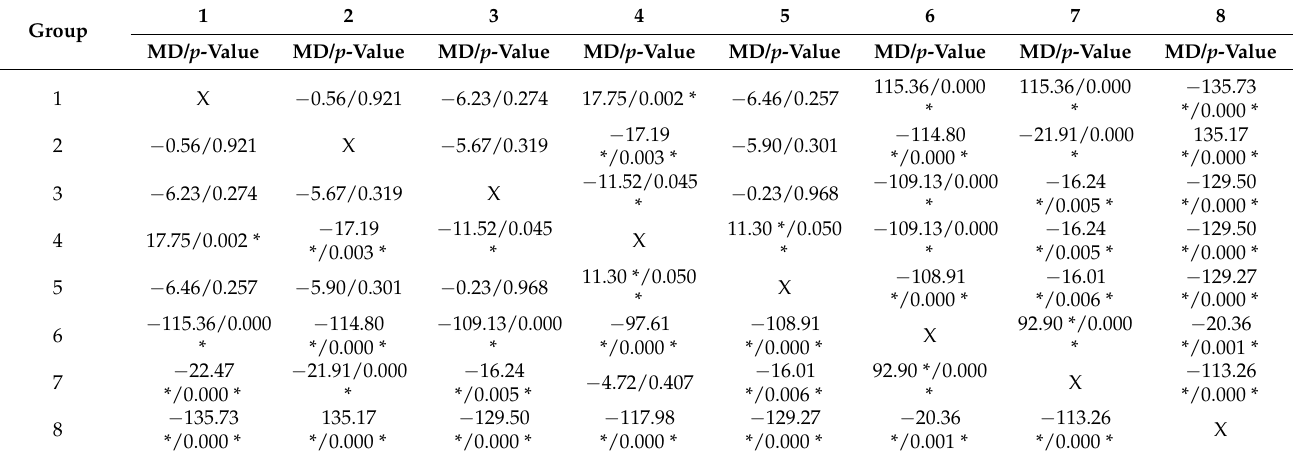
Table 3. Intergroup comparison of pull-off force in newton s(N) for groups 1–8 using one-way ANOVA